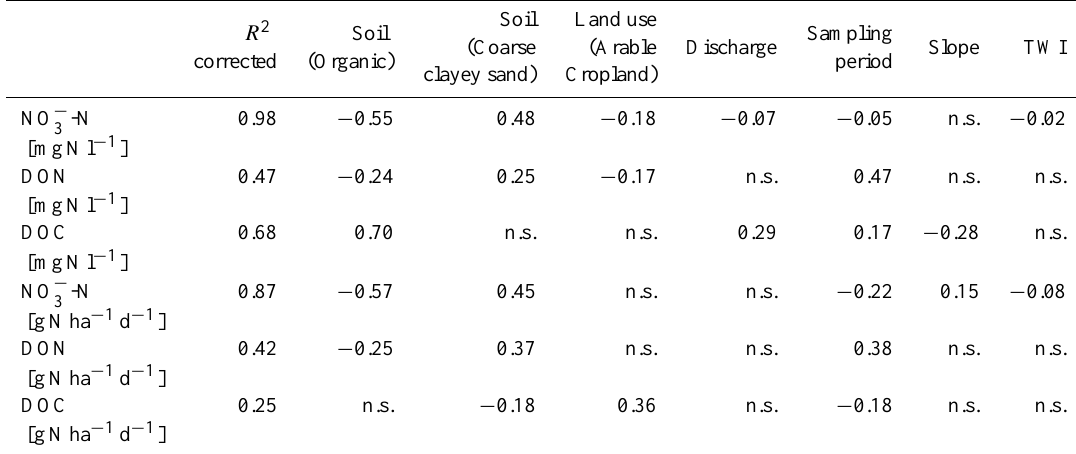
Table 3. Corrected R 2 and standardized beta coefficients of multivariate regression analyses (n.s.=not significant, TWI=topographic wet- ness index).